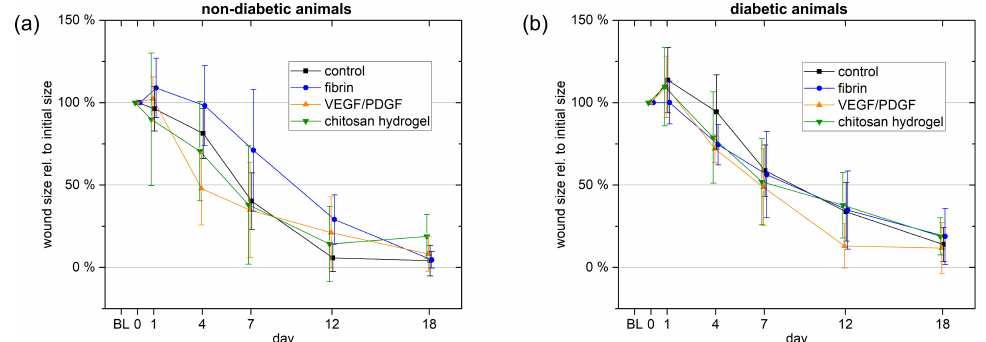
Figure 6. Wound size relative to the initial day as determined from photographs in ( a ) non-diabetic and ( b ) diabetic mice. The error bars represent the standard deviation.